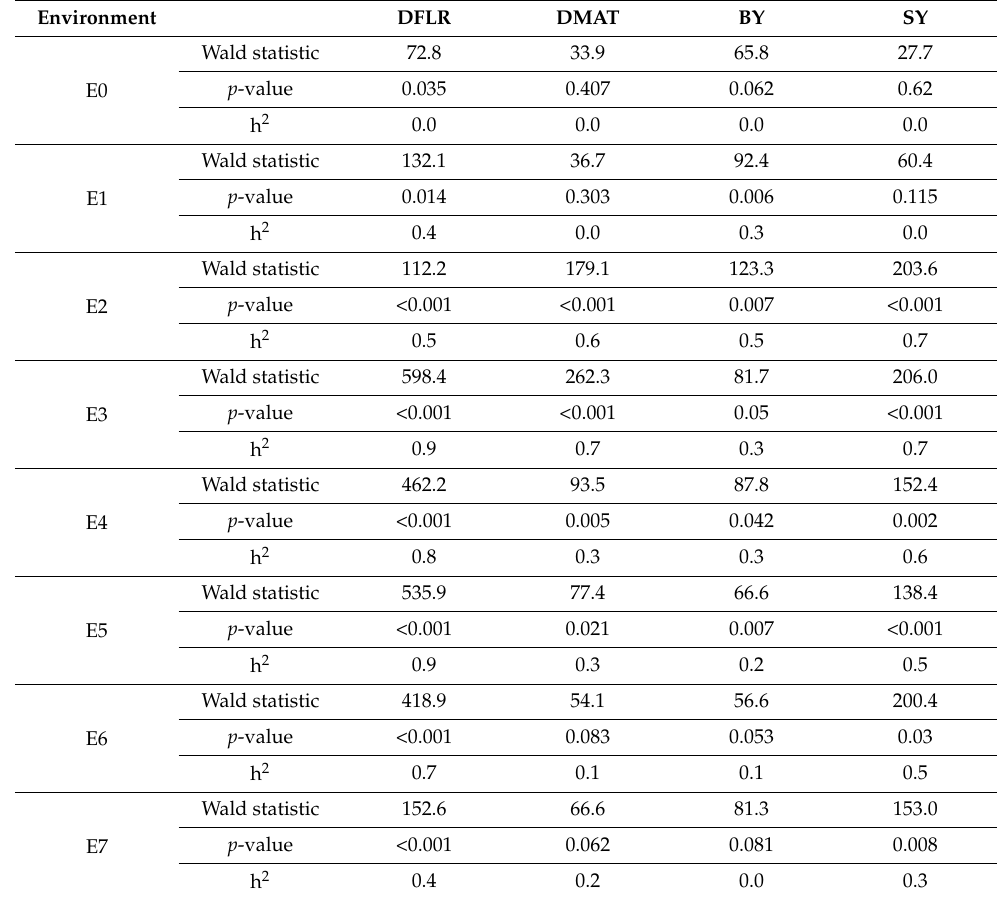
Table 2. Wald Statistic and p -value performed estimates for detecting differences across genotypes and narrow sense heritability (h 2 ) for phenological and agronomic